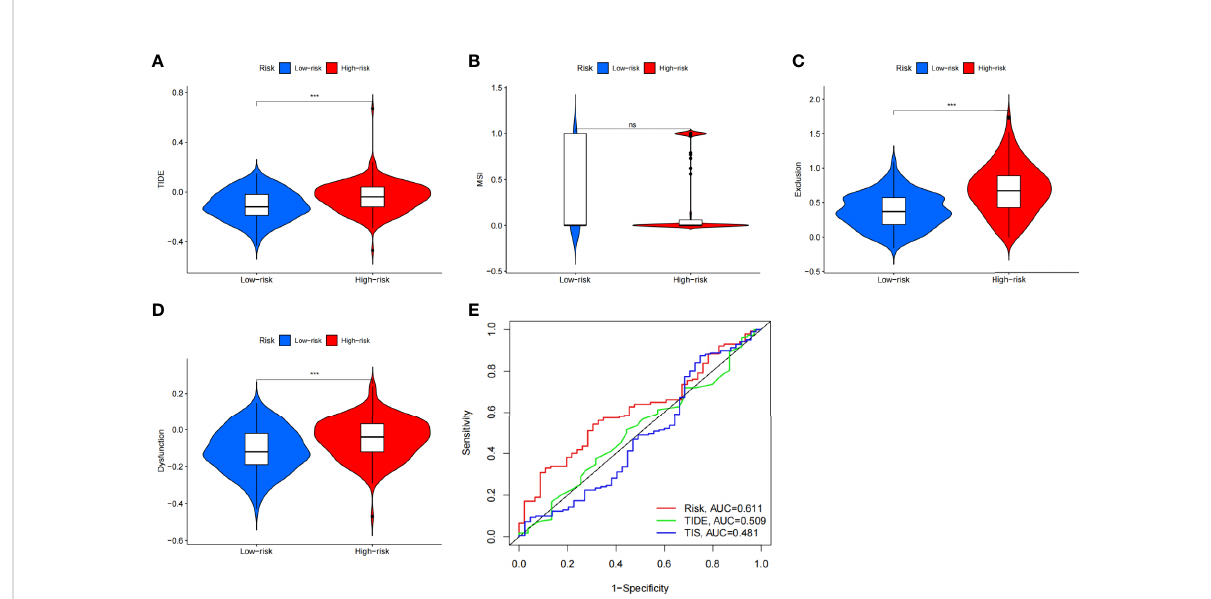
FIGURE 8 The prognostic value of CAFS-score in immunotherapy from TCGA cohort. (A – D) TIDE, MSI, T cell exclusion, and T cell dysfunction score in two CAFS-score subgroup, respectively. (E) ROC analysis of CAFS-score, TIDE, and TIS on OS in GC cohort. ***P<0.001, ns,